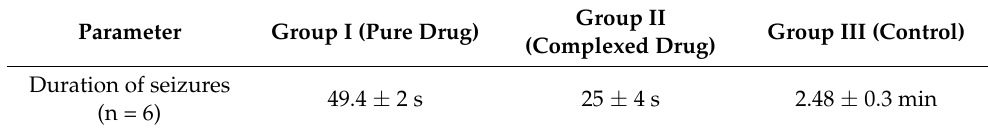
Table 3. In vivo anticonvulsant activity of CBZ and complexed CBZ in Wistar rats.